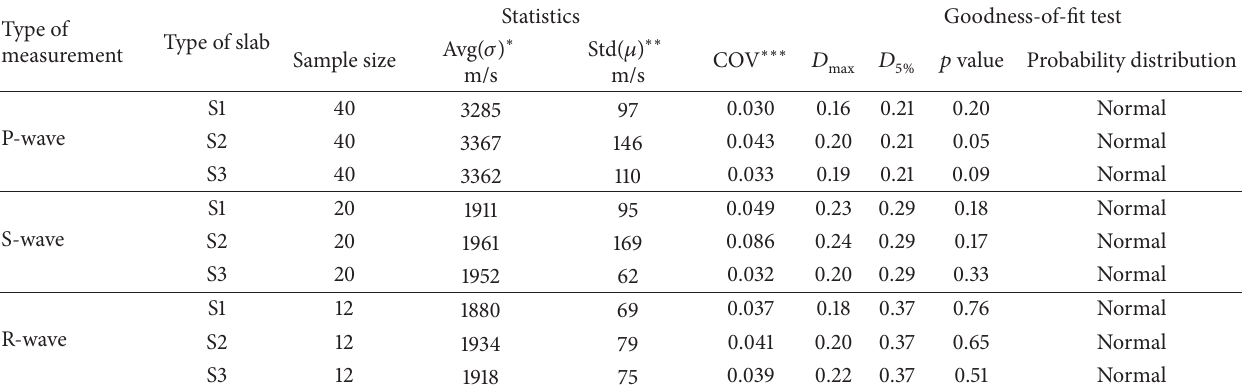
Table 5: The results of statistical analysis for slabs S1, S2, and